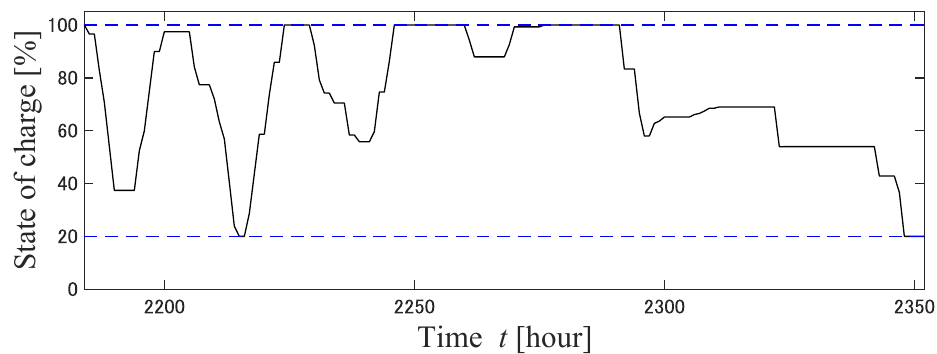
Figure 26. SOC of BESS from July 1 to 7 (Case 2).